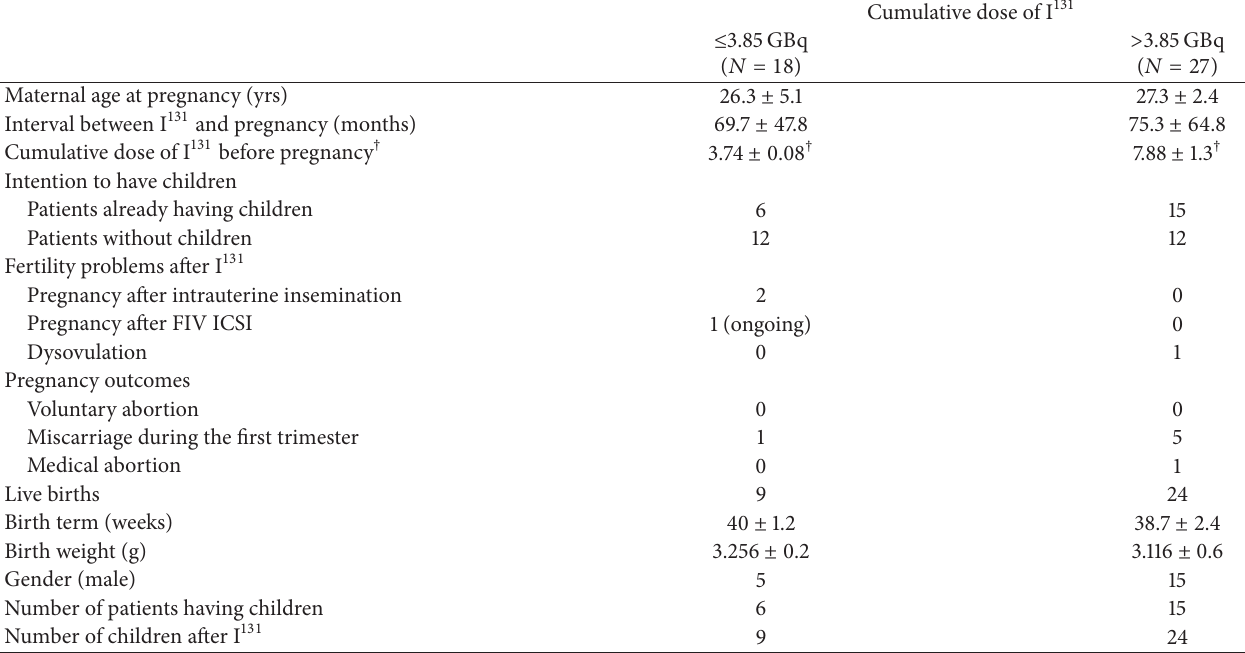
Table 3: Pregnancy outcomes after administration of I 131 in subjects diagnosed with differentiated thyroid cancer before age of 25